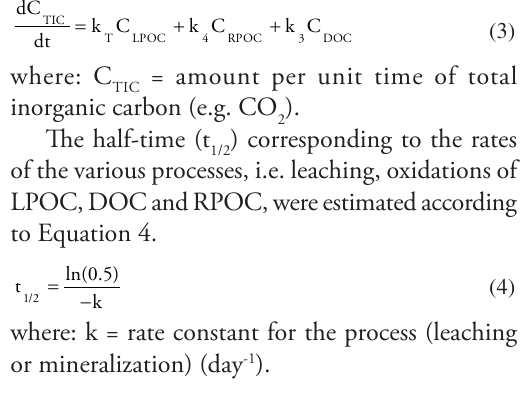
Table 1. Parameters of kinetic model (Equations 1 to 3). Where: LSPOC = particulate organic carbon (POC) frac- tions associated with protoplasmic portions (labile and soluble compounds); RPOC = POC refractory portions (e.g. cellulose, lignin); DOC = dissolved organic carbon; LPOC = POC labile compounds; TIC = total inorganic carbon; k = rate constant for the total mass loss related to leaching and oxidation of labile compounds [k T leaching rate constant; k = rate constant for the oxidation of labile compounds)]; k 2 for DOC; k = rate constant for oxidation (mineralization) of refractory 4